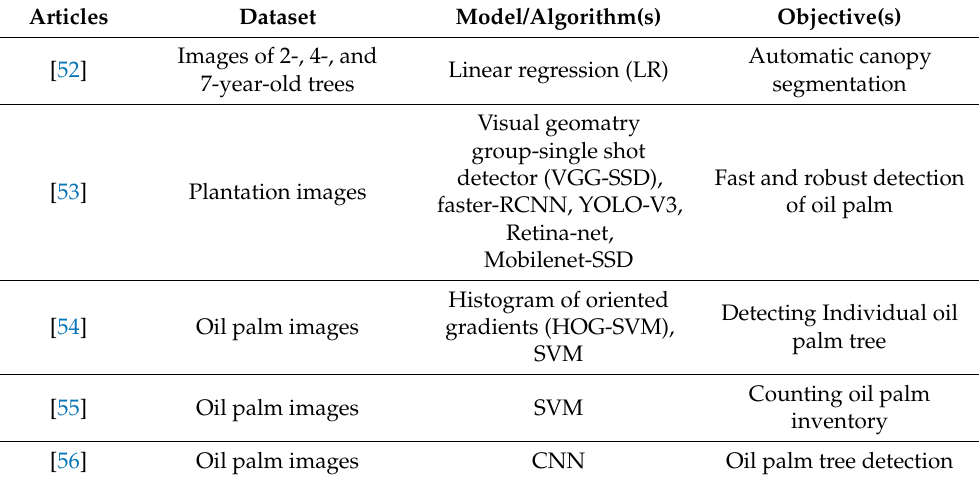
Table 4. Automated canopy segmentation/crop monitoring using